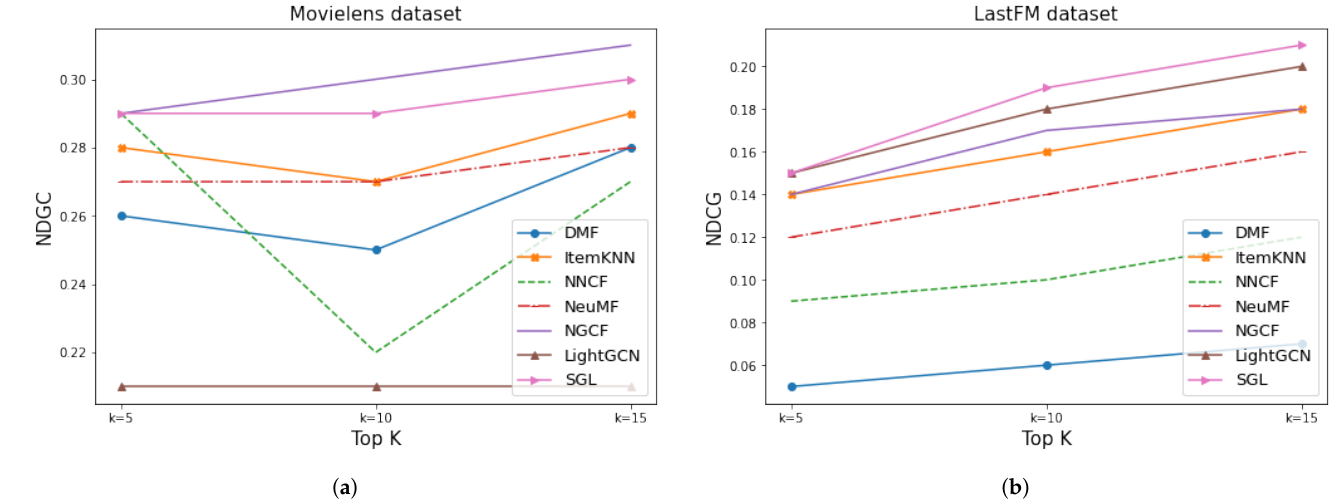
Figure 15. Results of NDGC for Movielens and LastFM. ( a ) MovieLens NDCG. ( b ) LastFM NDCG.